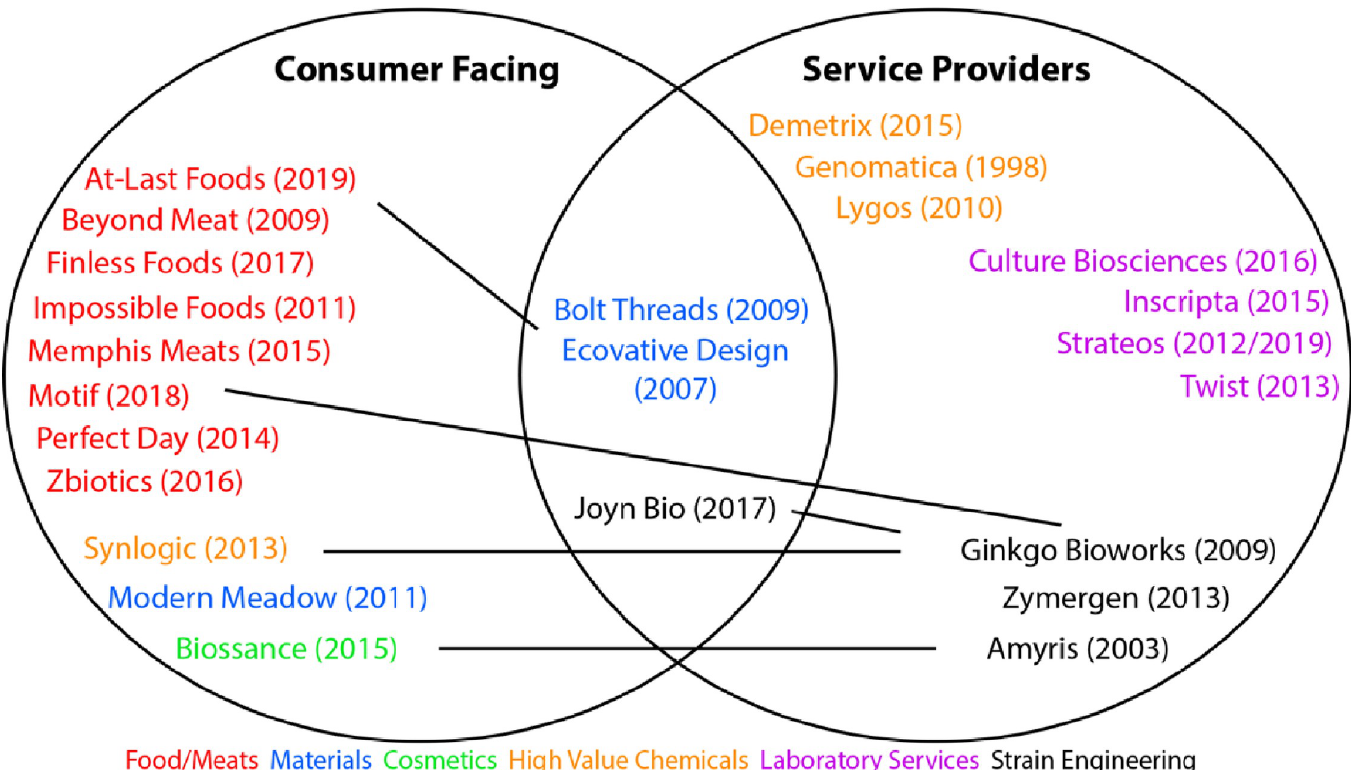
Fig 1. Overview of synthetic biology companies analyzed. Companies are categorized according to whether they are primarily consumer-facing companies or service providers, or have a hybrid model. Companies are also color-coded according to the focus of their key products / services. Year of company founding is indicated in parentheses. Solid lines between companies indicate spin-out companies and/or strategic investments by the older company.